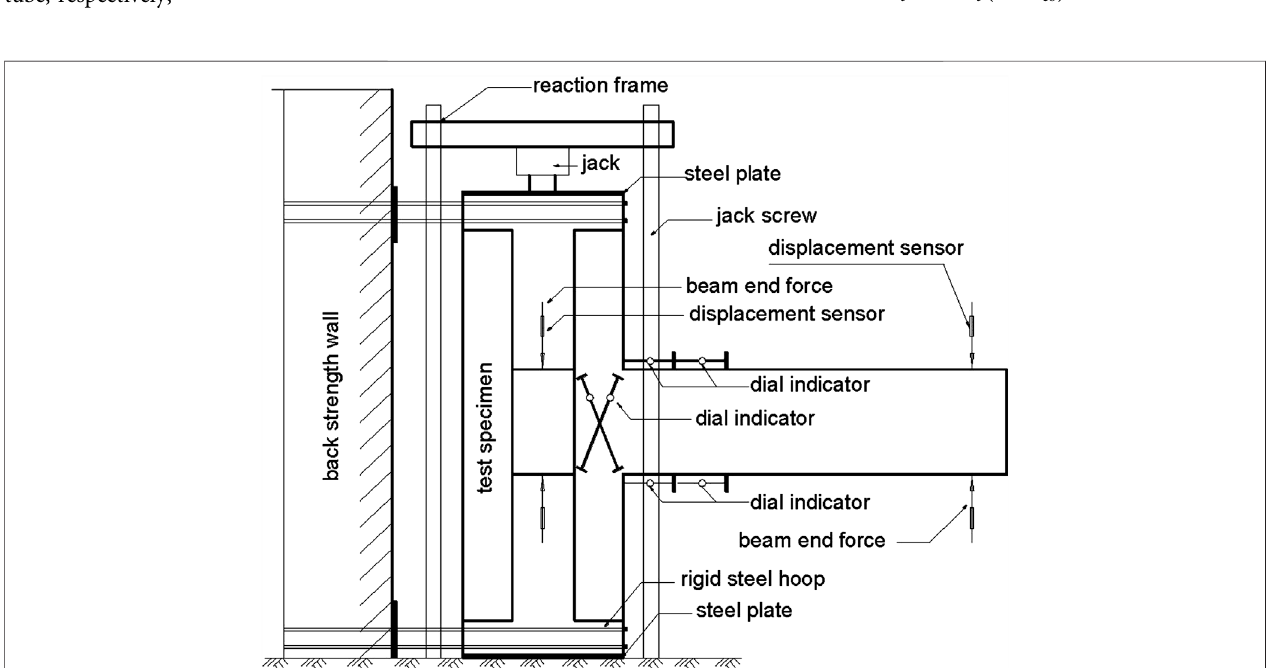
FIGURE 9 | Drawing of loading devices (Xiang et al.,